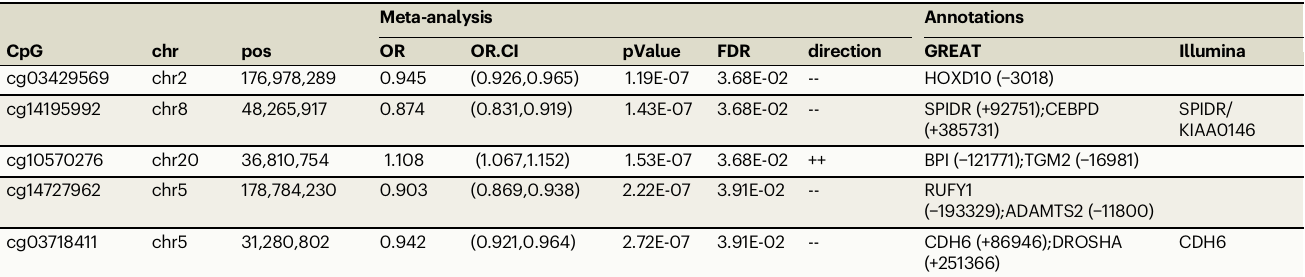
Table 1 | In epigenome-wide meta-analysisof blood DNA methylation in ADNI and AIBL datasets, 5 CpGs were signi fi cant in the Alzheimer ’ s disease (AD) vs. cognitive normal groups comparison at 5% false discovery rate after multiple comparison